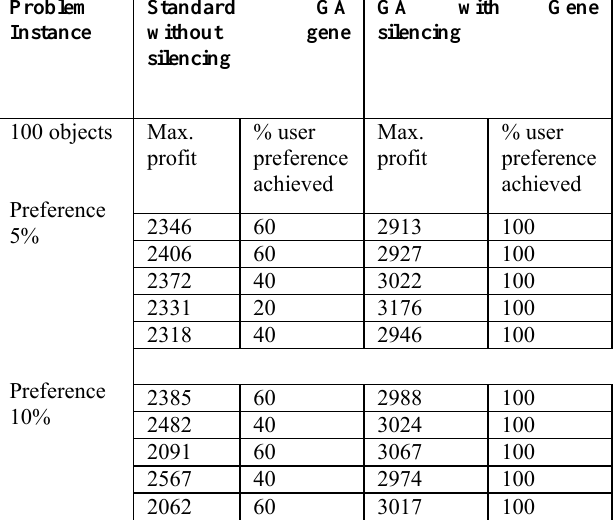
Table 1. Experiment-1 with 100 Objects and Preference of